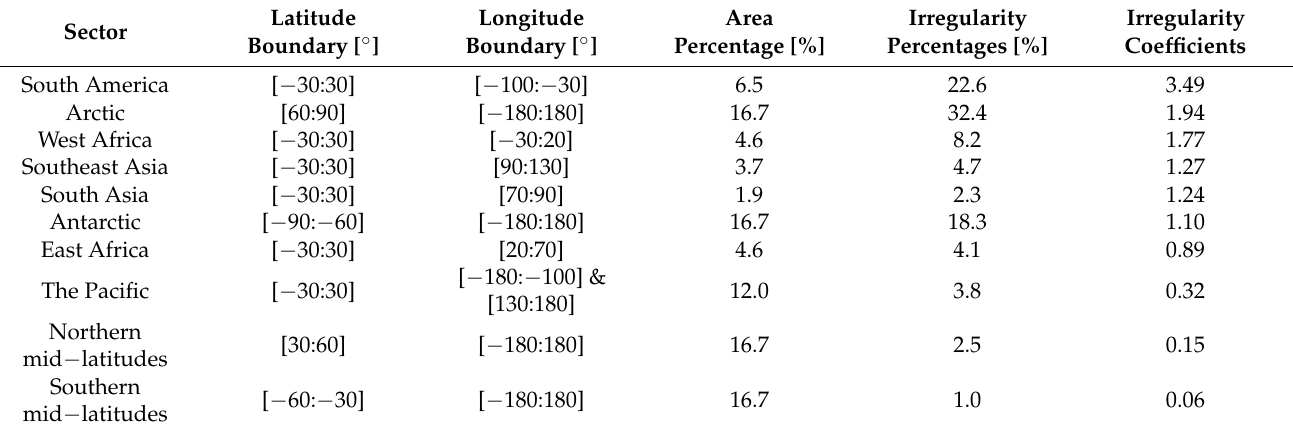
Figure 17. Percentages of ionospheric disturbance in different sectors of the equatorial region. South America accounts for the majority of disturbances at 22.6%, followed by West Africa at 8.2%. Southeast Asia and East Africa have roughly the same amounts of disturbances with 4.7% and 4.1%m respectively. The vast Pacific Ocean area accounts for only 3.8% of the total disturbances, while South Asia is the region that accounts for the least amount of irregularities (only 2.3%). Table 5. Comparison of the levels of ionospheric disturbances in different parts of the world.